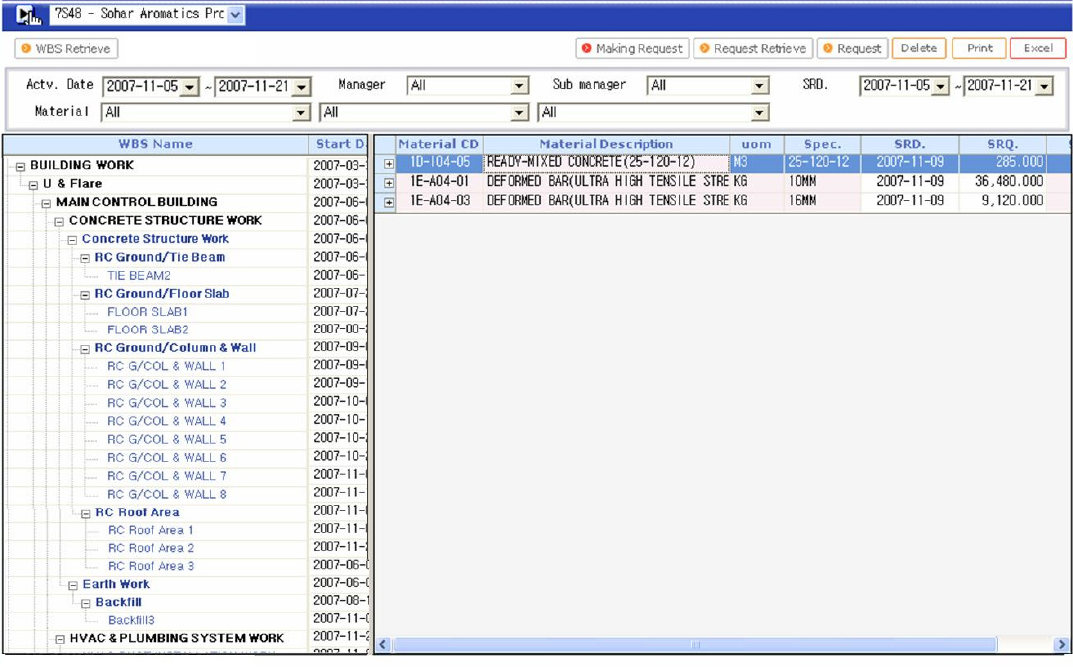
Fig. 12. Material list related to Act. 1